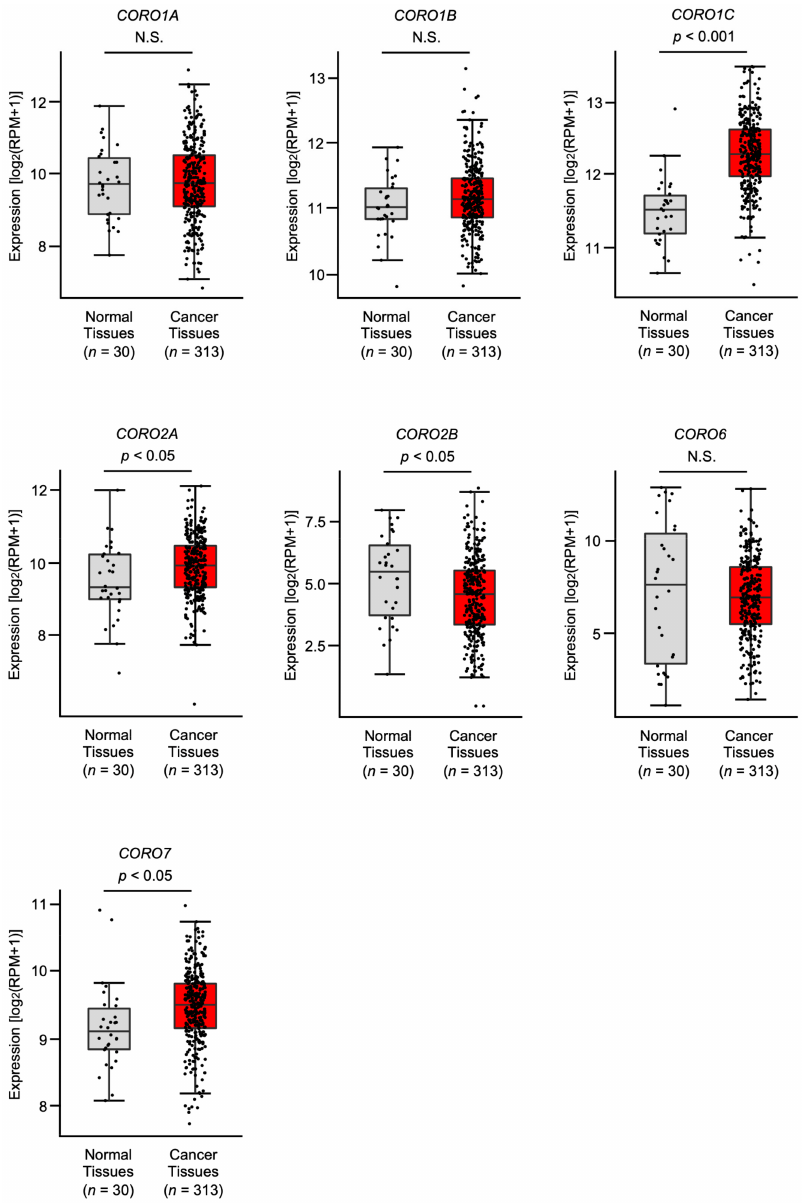
Figure 1. Expression of all members of coronin family by TCGA-OSCC analysis. Expression levels of CORO1A , CORO1B , CORO1C , CORO2A , CORO2B , CORO6, and CORO7 in OSCC tissues. A total of 313 OSCC tissues and 30 normal epithelium tissues were analyzed (N.S., not significant). To determine the clinical effectiveness, a clinicopathological analysis of the coronin family was performed using TCGA-OSCC data. Patients with high expression of CORO1B and CORO2A had a significantly worse prognosis compared with those with low ex- pression (Figure 2A and Table S1). Multivariate Cox regression analysis was performed about expression levels of CORO1B and CORO2A with other expected prognostic factors (age, disease stage, and pathological grade). As result, CORO2A expression levels were independent prognostic factors (Figure